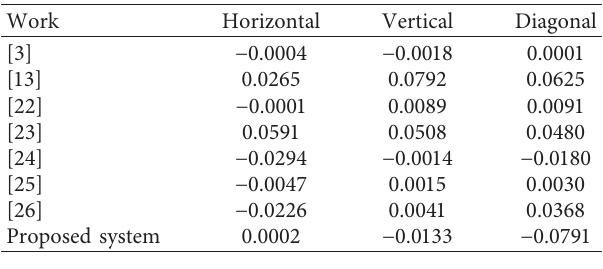
Table 5: Comparative study of the correlation coefficient for the Lena